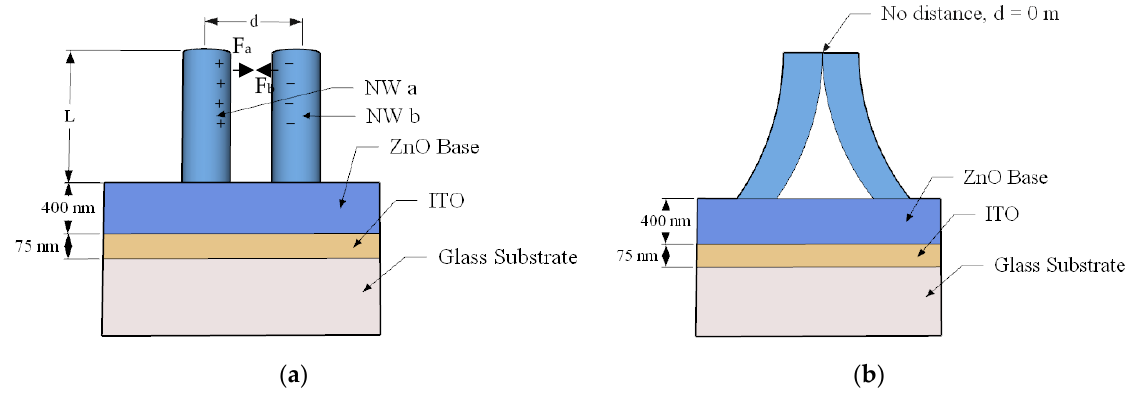
Figure 1. Fabricated structure ( a ) straight ZnO NWs and ( b ) bent ZnO NWs.